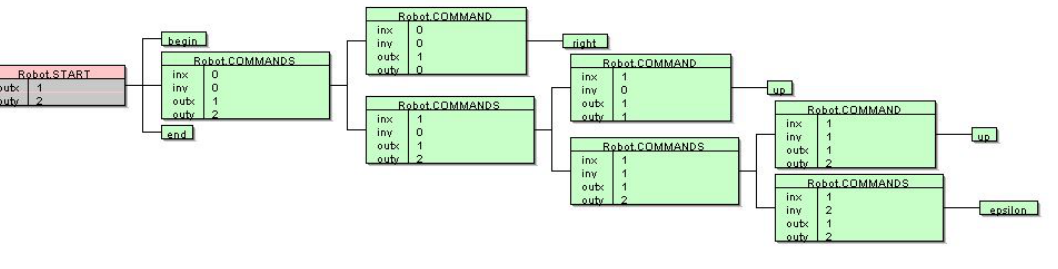
Figure 6. Example of Robot language. Listing 8. AG for the Robot